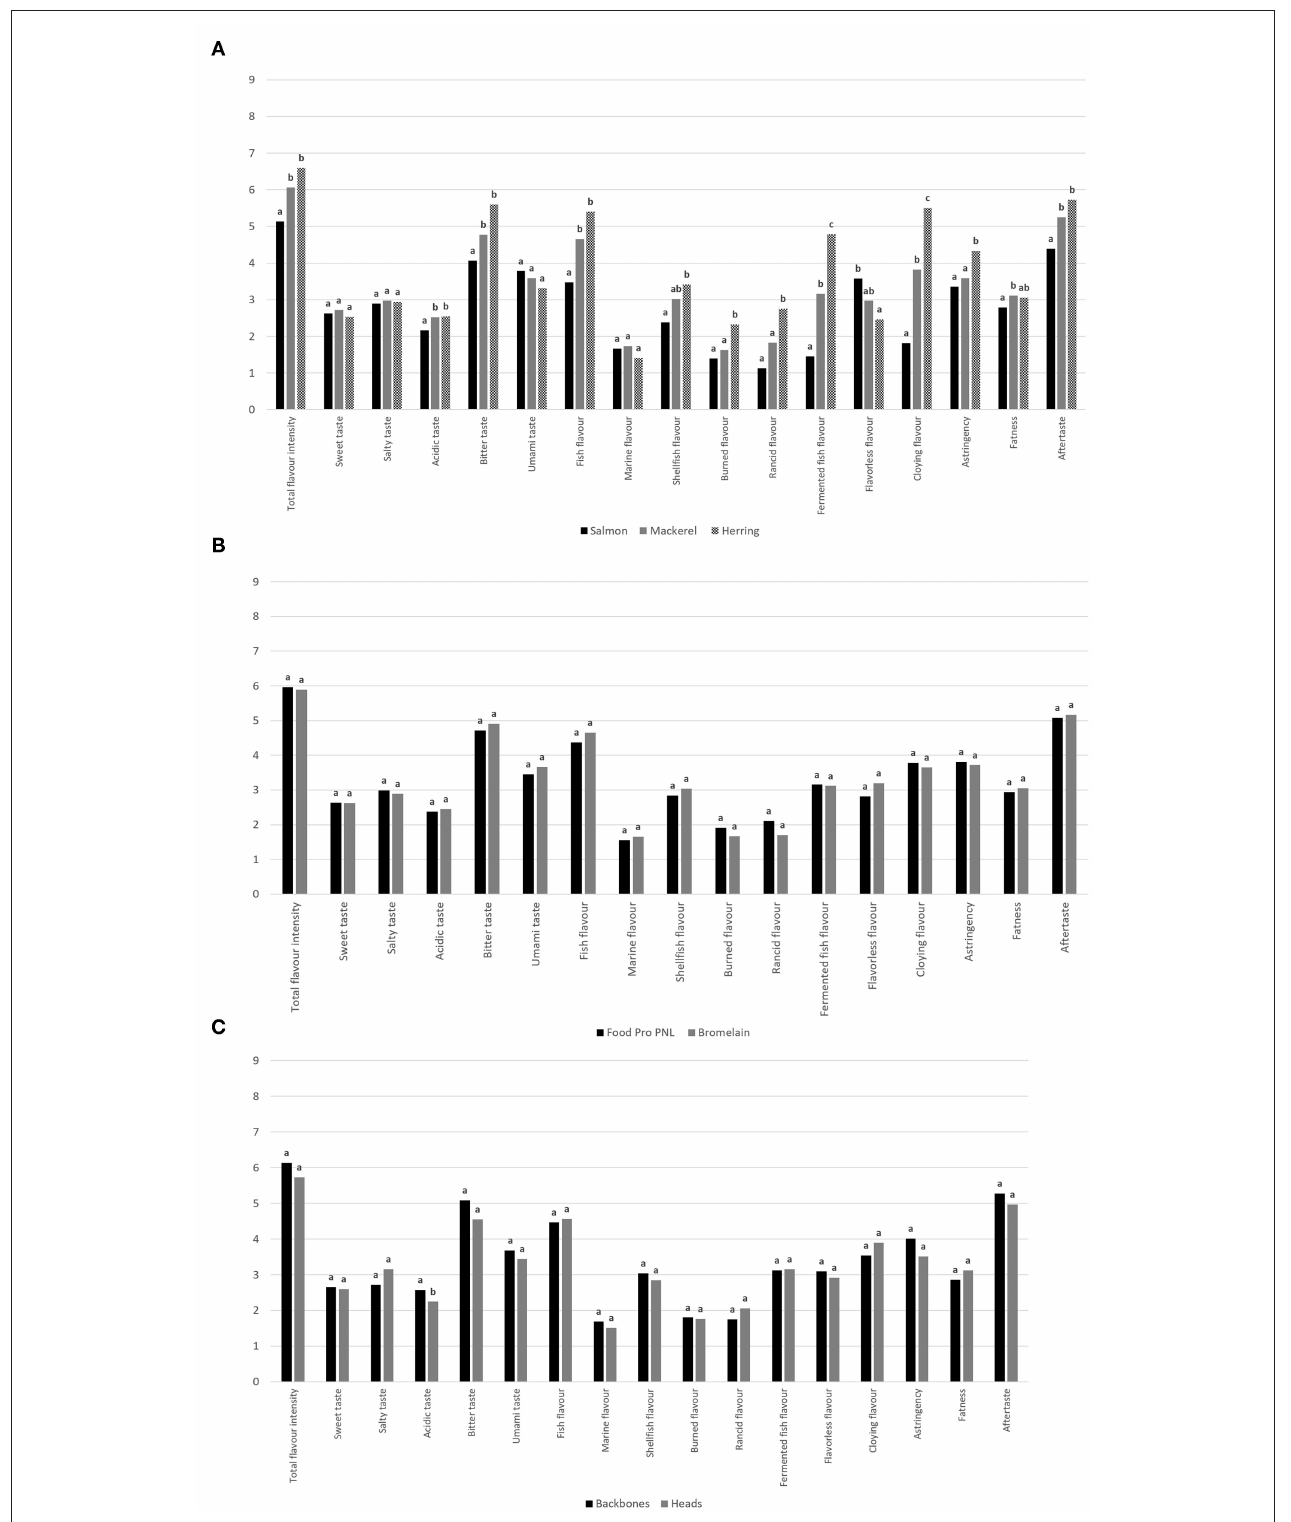
FIGURE 2 | Mean intensity of sensory attributes of protein hydrolysates based on (A) salmon, mackerel, and herring, (B) Food Pro PNL and Bromelain, and (C) heads and backbones. Different letters indicate statistical difference within each variable ( p < 0.05) based on mixed model ANOVA and Tukey’s multiple comparison test.